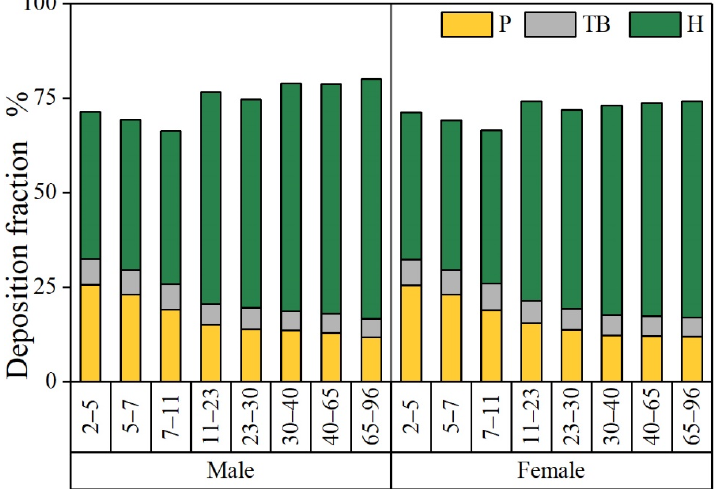
Figure 2. Deposition fractions of PM 2.5 in different organs of the human body for different popula- tion groups. P (yellow portion of bars): pulmonary region of the deposition fraction. TB (the grey portion of bars): tracheobronchial region of the deposition fraction. H (green portion of bars): the upper respiratory tract above the pharynx of the deposition fraction.